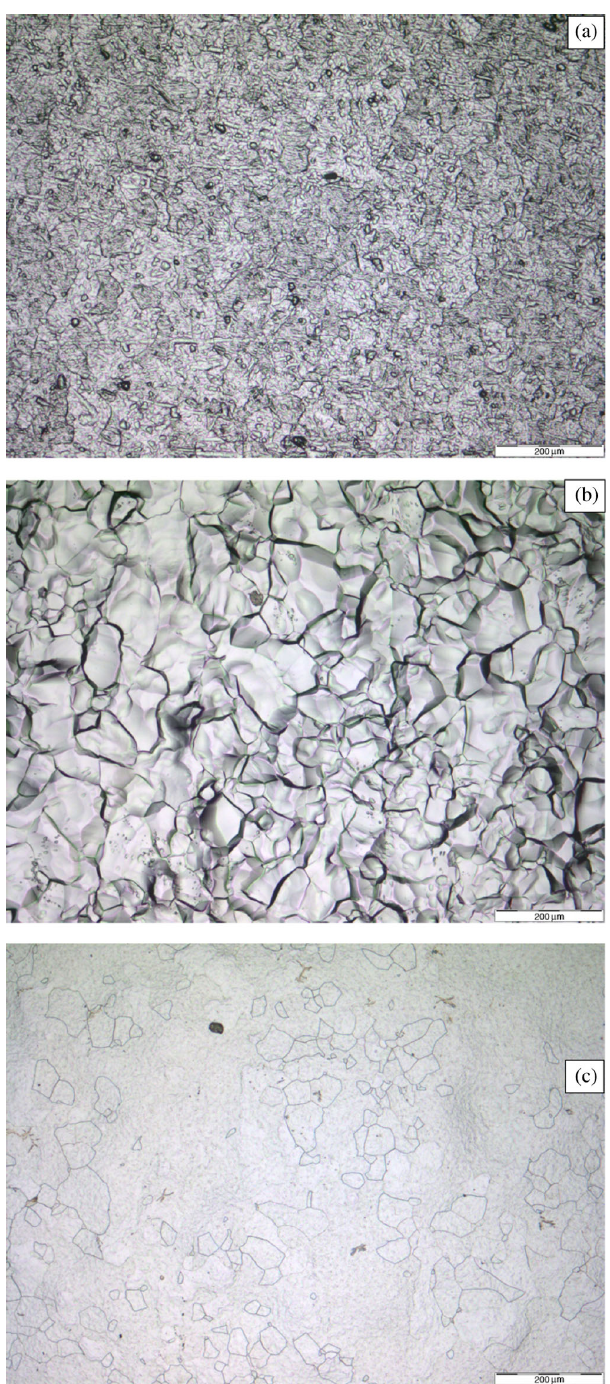
FIG. 1. Opticalimagesofniobiumsheet(a)asreceived,(b)after BCP, and (c) after EP. The white bar at the lower right of each image corresponds to 200 (cid:1) m . Optical microscopy is courtesy of Thomas Kiederowski, Institute for Laser Technology,